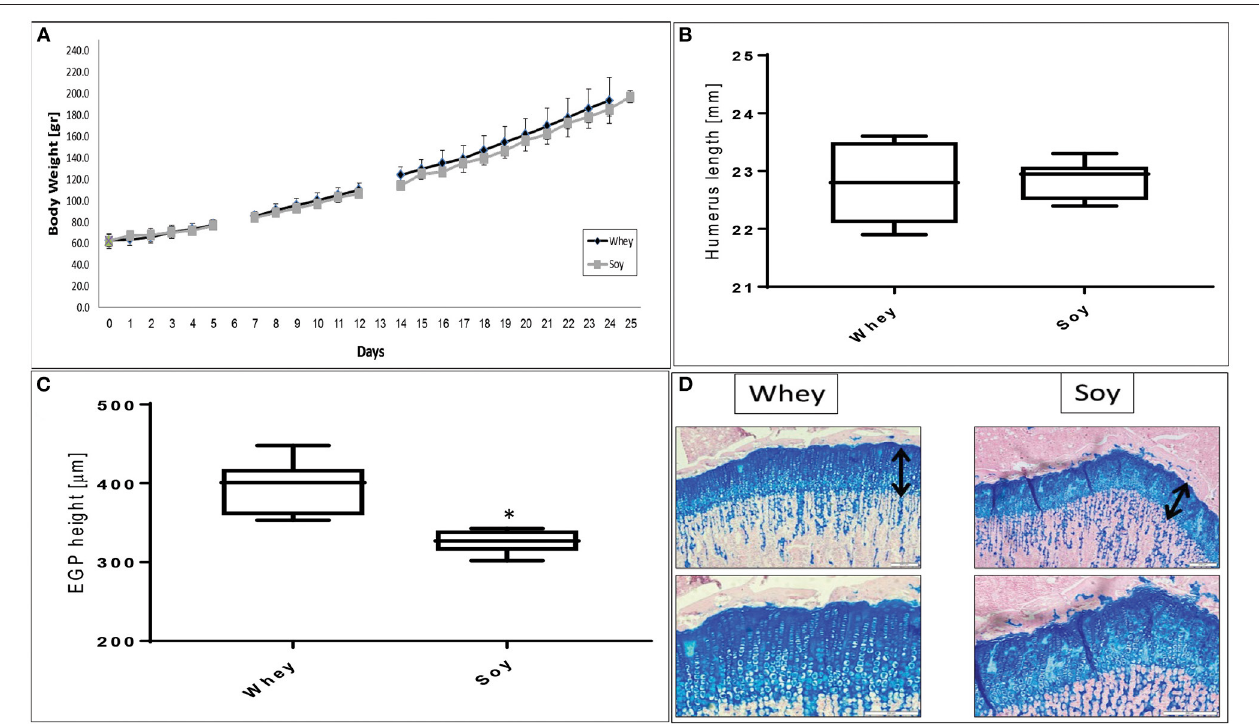
FIGURE 2 | Pair-fed experiment. (A) Animal body weight, (B) humerus length, (C) EGP height, and (D) representative stained sections of the EGP (upper panel-magnification × 10; lower panel magnification X 20). Values are means ± SD. Statistical analysis was done by Student’s T -test. The asterisk (*) within the graphs designates significant differences at p < 0.05. The black arrows indicate the height of the growth plates. (B,C) The box plot shows the minimum, first quartile, median, third quartile, and maximum of humeru length (B) and EGP height (C) after 24 days of pair-fed feeding. EGP, epiphyseal growth